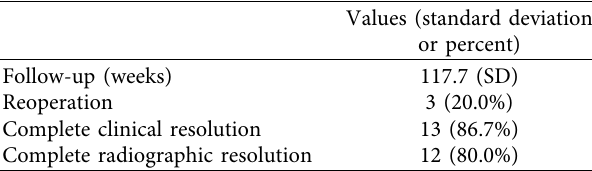
Table 2: Postoperative